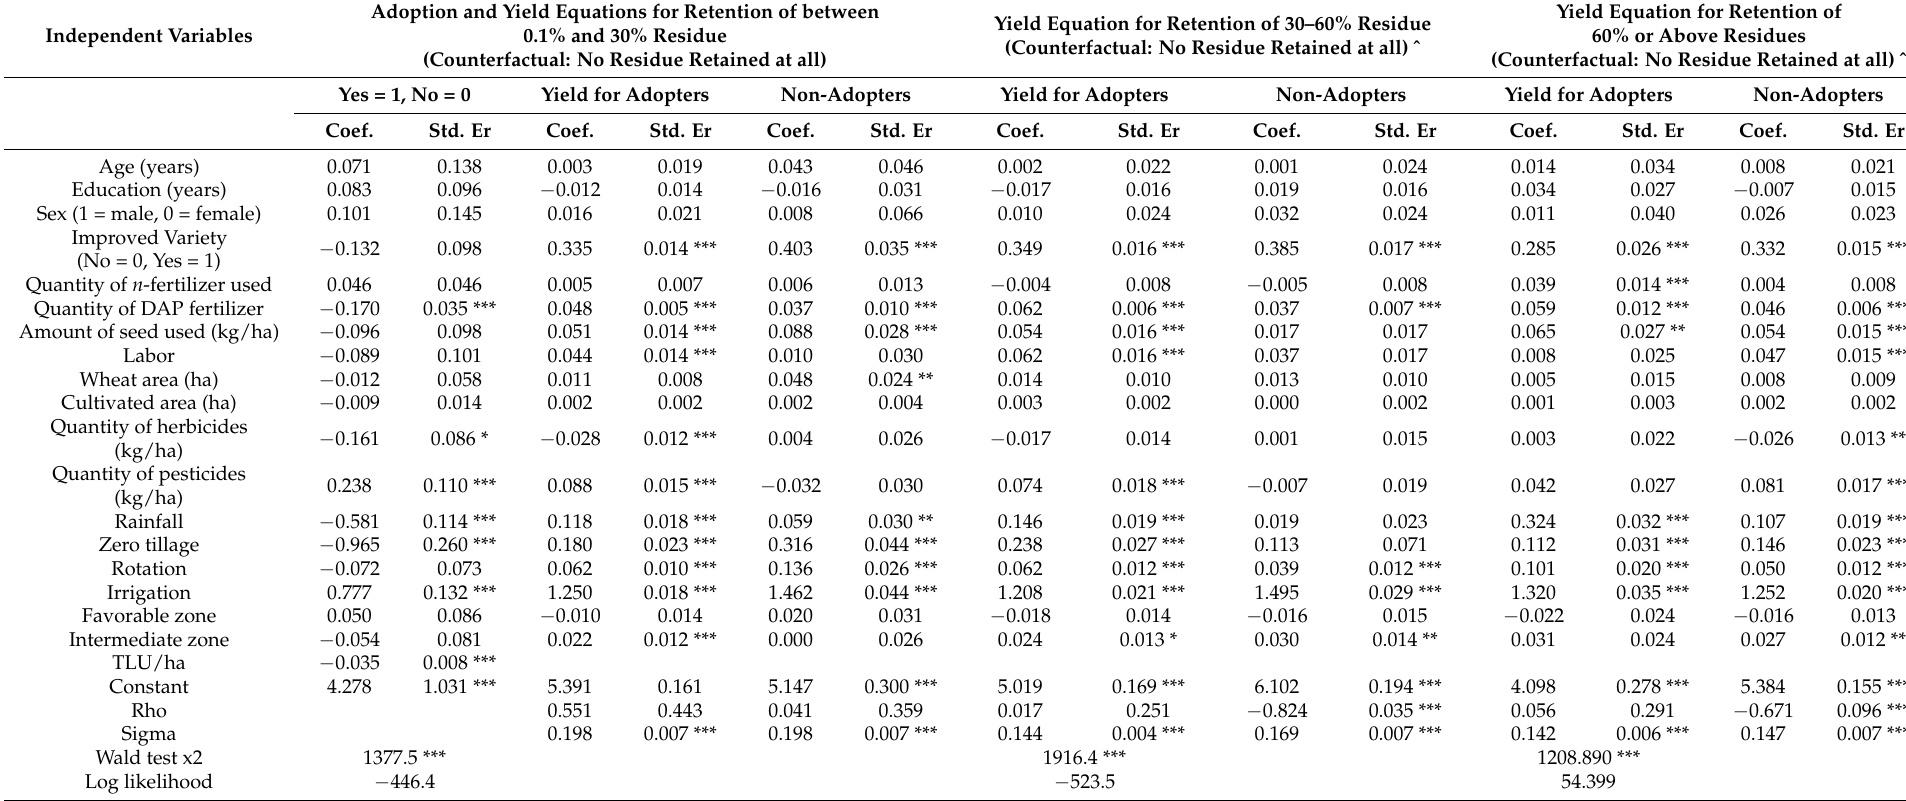
Table 3. Results of the endogenous switching regression models for measuring impacts of retaining different levels of residue on wheat yield